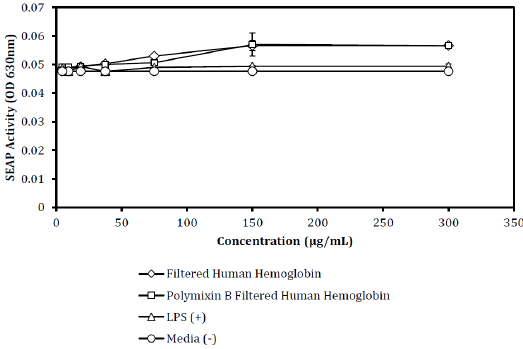
Figure 3. HEK-Blue Null cells that lack the TLR4 expression vector, but express the NF- κ B reporter plasmid, were incubated overnight with TLR4 ligands. A serial dilution of each ligand was performed. The non-filtered Hb (Diamonds), polymyxin B extracted Hb (Squares), LPS (Triangles), and control media (Circles) were all prepared as noted in Figure 1. Secreted alkaline phosphatase (SEAP) activity was assessed by removing 20 uL, mixing the aliquot with substrate, and measuring the absorbance at 630 nm. The data is shown as the mean (+/ − SEM) absorbance for SEAP substrate conversion. Due to the scaling of the figure, the lines may appear unrelated — however SEAP activity was minimal (0.2% compared to Figure 1 lipopolysaccharide (LPS) control; HEK TLR4 cells) and using ANOVA comparisons of the regressions, no significant difference was observed between polymyxin B-treated and non-treated HEK-Blue Null2 ( p > 0.05).